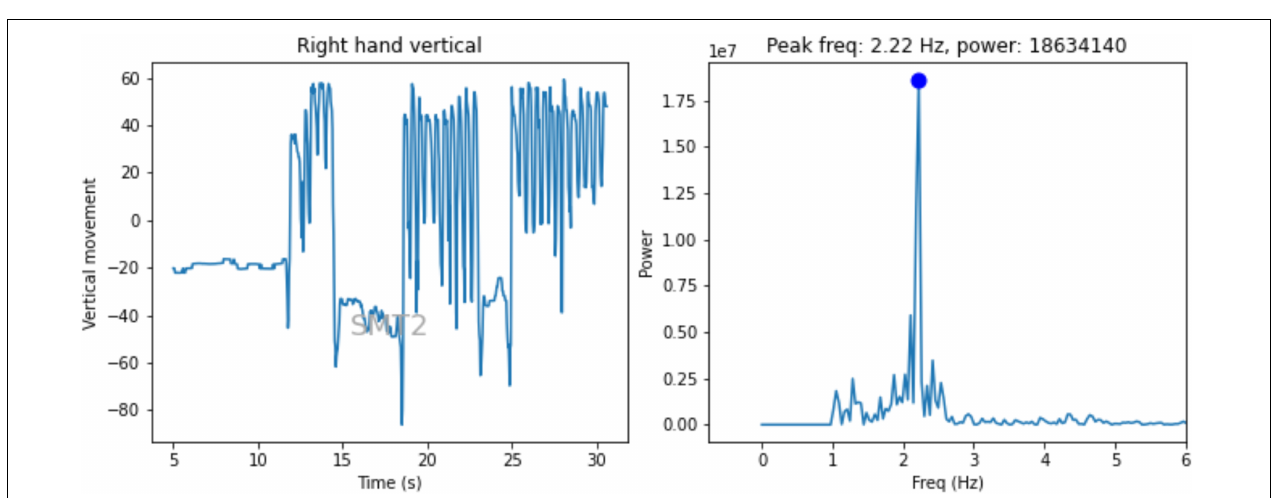
FIGURE 3 | (A) The graph shows the vertical movement of the toddler’s right hand using averaged OpenPose data over their second spontaneous motor tempo trial, which contained three bursts of drumming. (B) The graph shows the power spectrum derived using fast fourier transform of the data, revealing a spontaneous motor frequency of 2.22